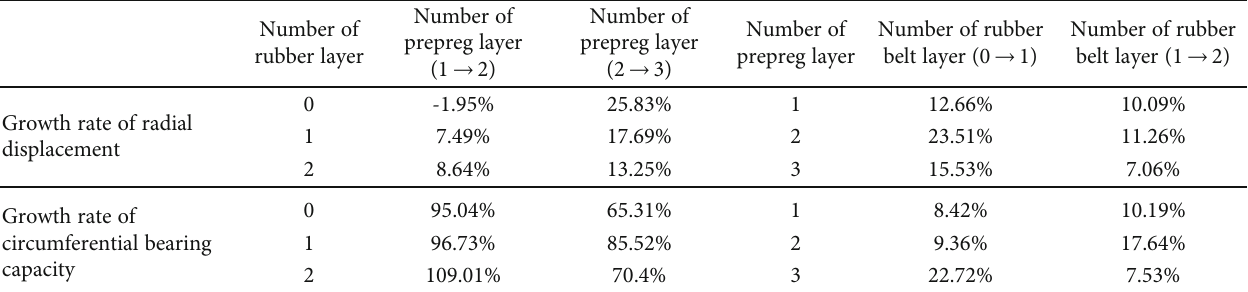
Table 5: The in fl uence of the number of the prepreg wrap and rubber belt layers on the circumferential bearing capacity and radial displacement of the